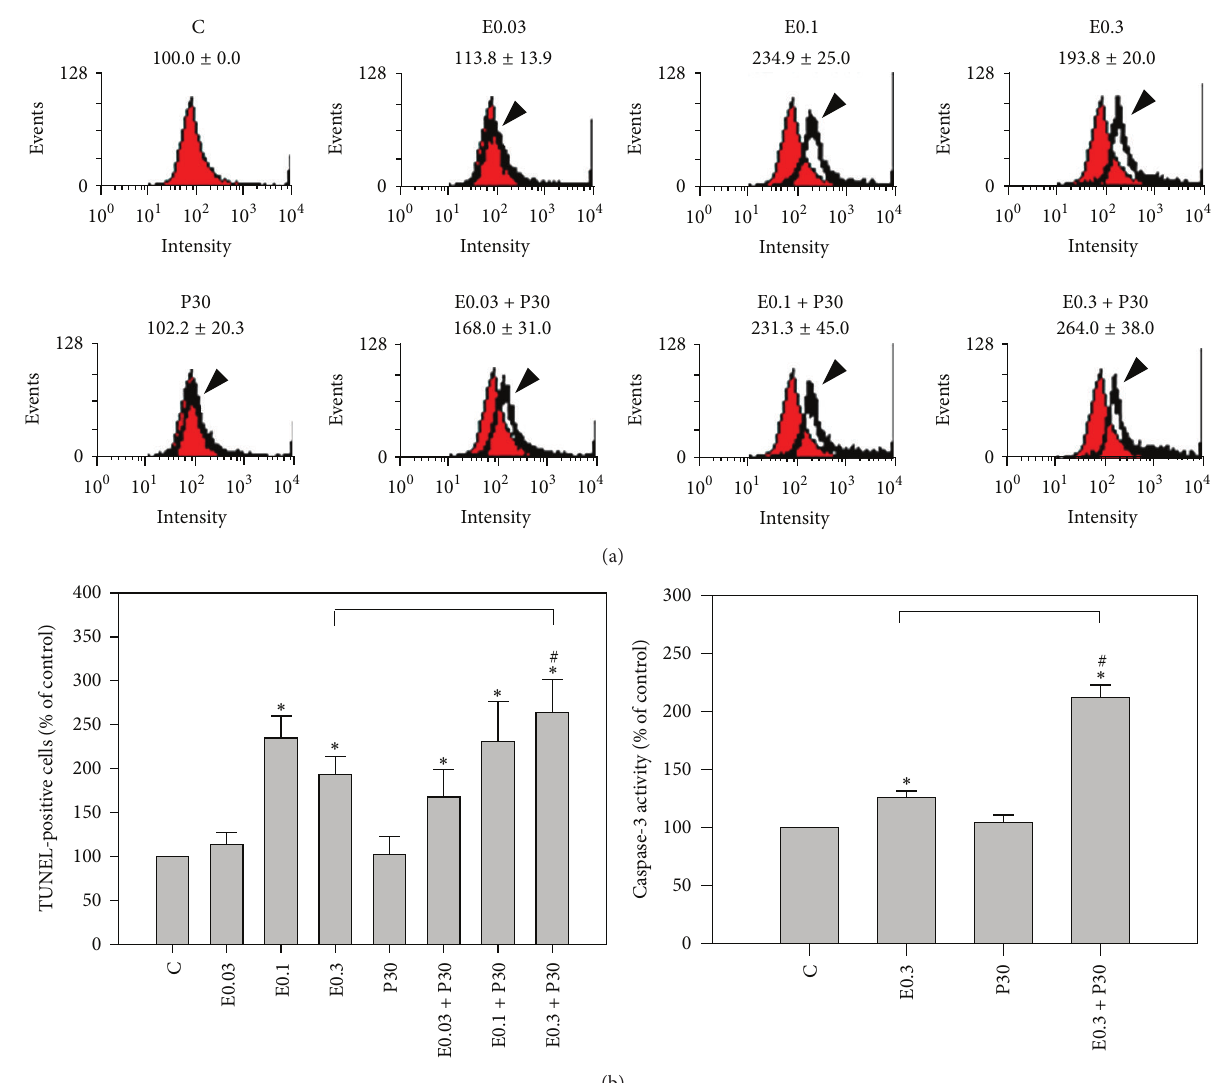
Figure 2: Apoptosis induction by epirubicin without or with progesterone addition. HA22T/VGH cells were treated with indicated concentrations of epirubicin without or with 30 𝜇 M progesterone for 24 h and evaluated by (a) TUNEL staining or (b) caspase-3 activity. Results are expressed as the mean ± standard deviation (S.D.) for three separate experiments. C: untreated cells, E0.03: 0.03 𝜇 M epirubicin, E0.1: 0.1 𝜇 M epirubicin, E0.3: 0.3 𝜇 M epirubicin, and P30: 30 𝜇 M progesterone. ∗ 𝑃 < 0.05 compared to the untreated controls. # 𝑃 < 0.05 compared to the corresponding epirubicin-treated